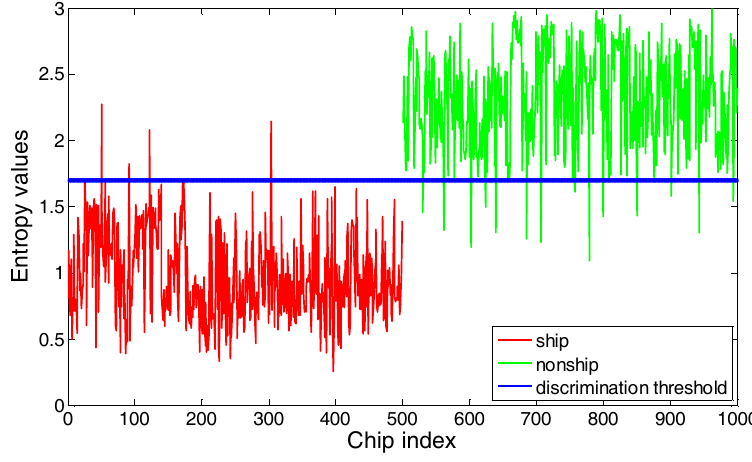
Figure 8. The entropy values of the chips.